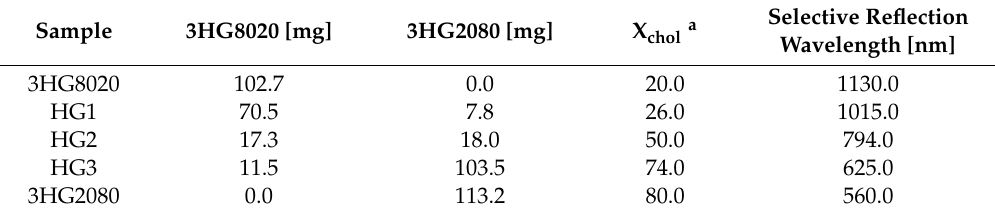
Table 2. The compositions and selective reflection properties of all the samples.